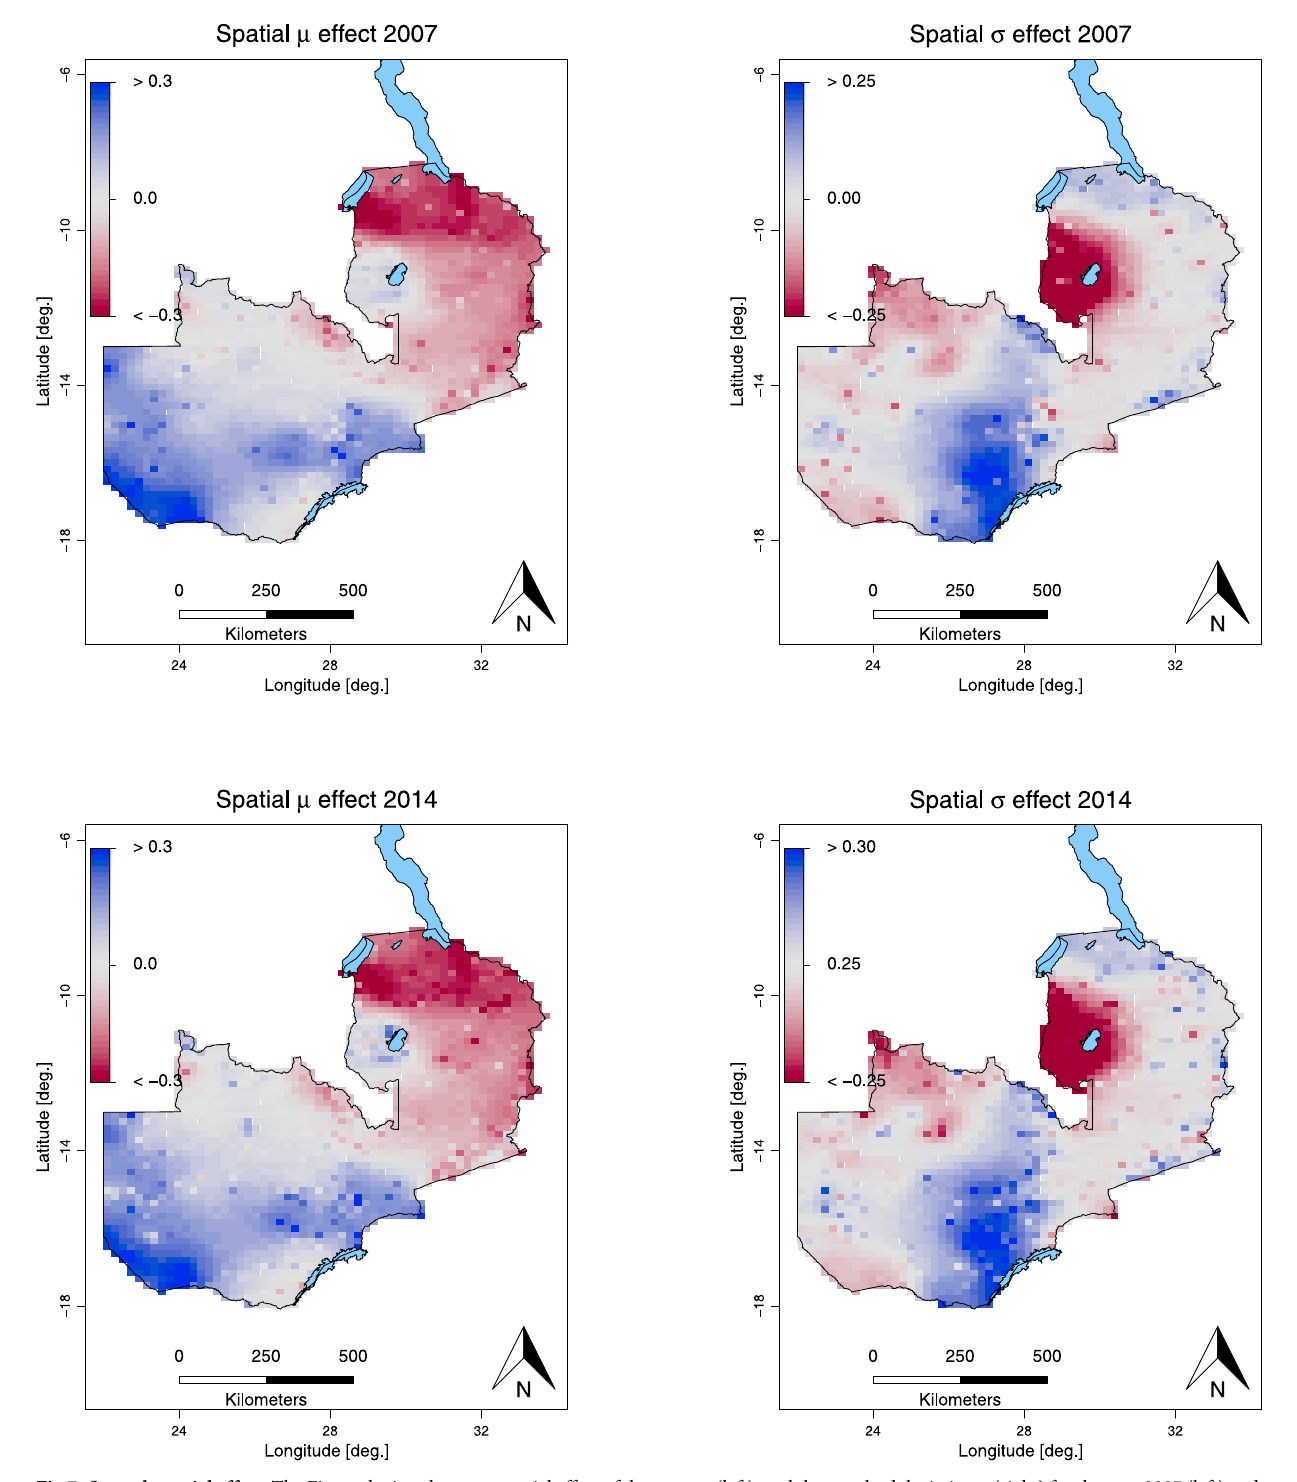
Fig 7. Smooth spatial effect. The Figure depicts the mean spatial effect of the mean μ (left), and the standard deviation σ (right) for the year 2007 (left) and the year 2013/14 (right). Source : Demographic and Health Surveys (data) and Database of Global Administrative Areas (boundary information); calculation by authors. The shapefile used to create these maps is republished from [54] under CC BY license, with permission from Robert J. Hijmans, original copyright [2021].